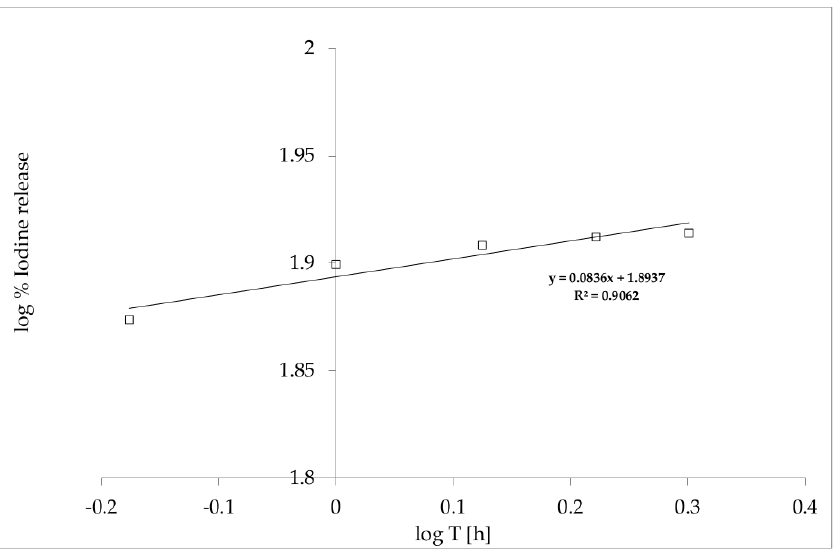
Figure 5. Korsmeyer–Peppas model of the kinetic release of I 2 from PVA/HPMC_B film with incorporated PVP-I.